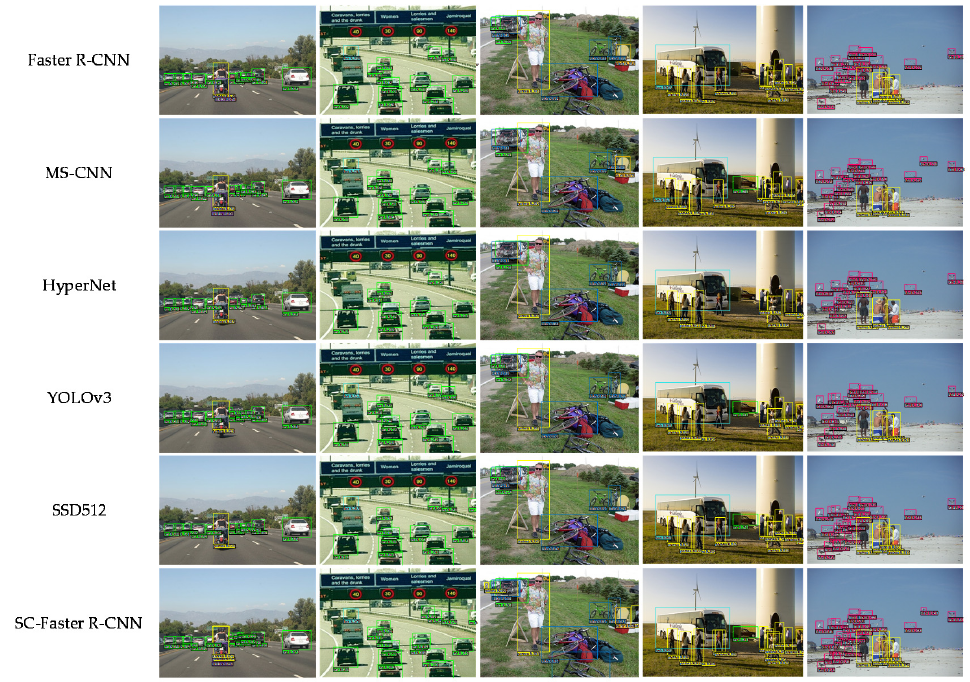
Figure 6. Proposed algorithm and comparison algorithms on detection effect of different sizes of objects in 07 + 12 dataset.